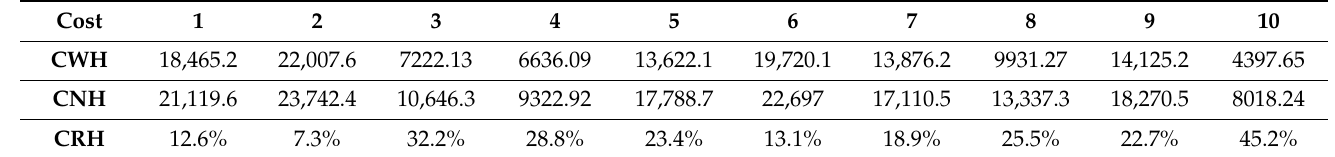
Table 5. Computational results of the second instances set in Case 2.